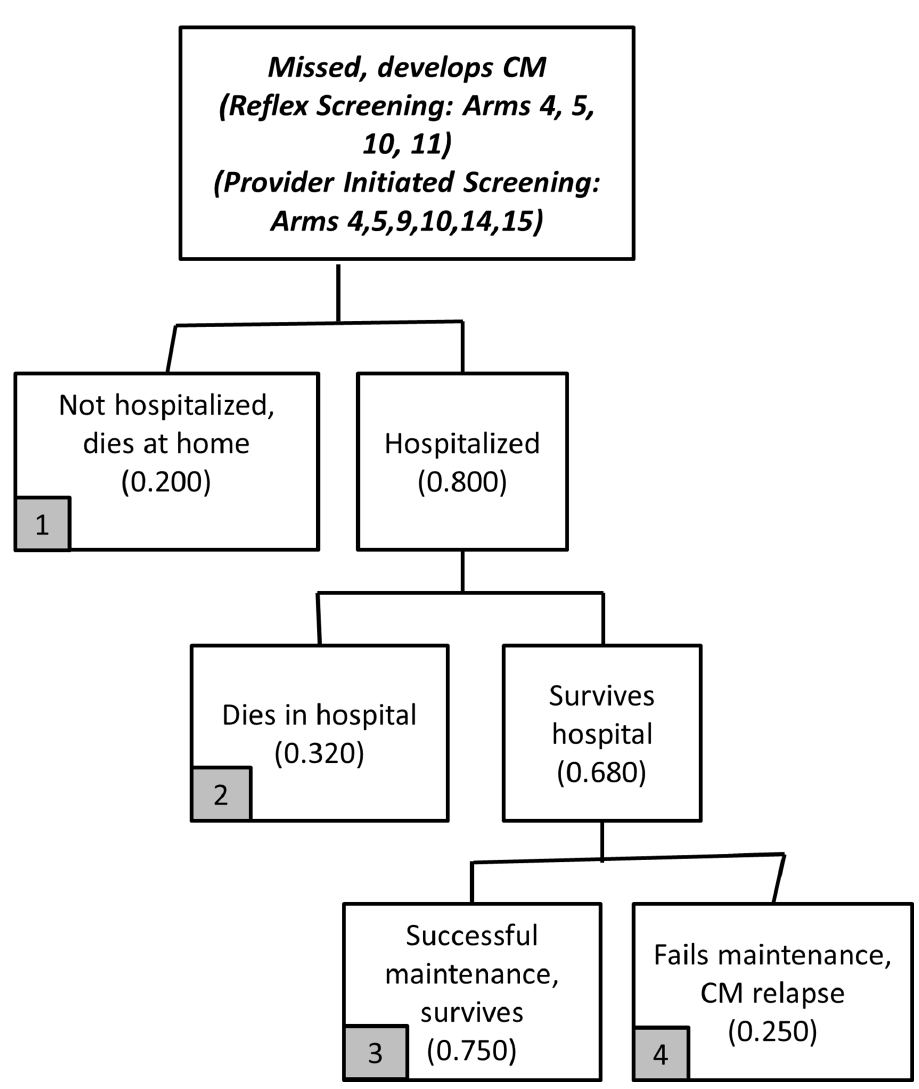
Fig 8. Treatment model flowchart (Panel